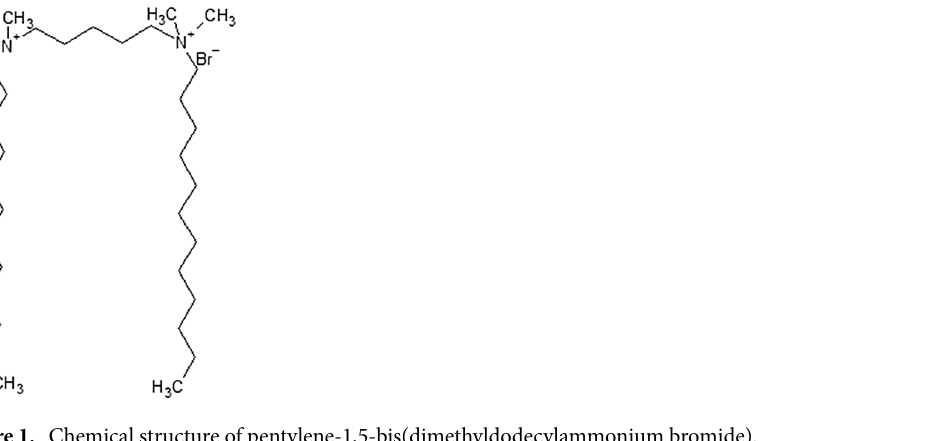
Figure 1. Chemical structure of pentylene-1,5-bis(dimethyldodecylammonium